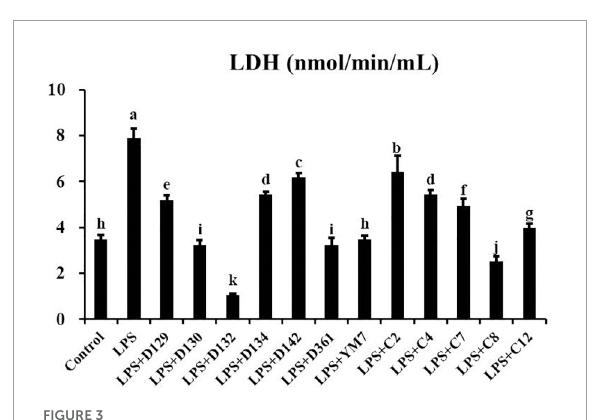
FIGURE3 The levels of LDH released by MDCK cells treated with hemp leaf extracts and LPS-induced inflammation. Data are expressed as the mean ± SD ( n = 3). The superscript letters (a–k) indicated statistical significance at p <